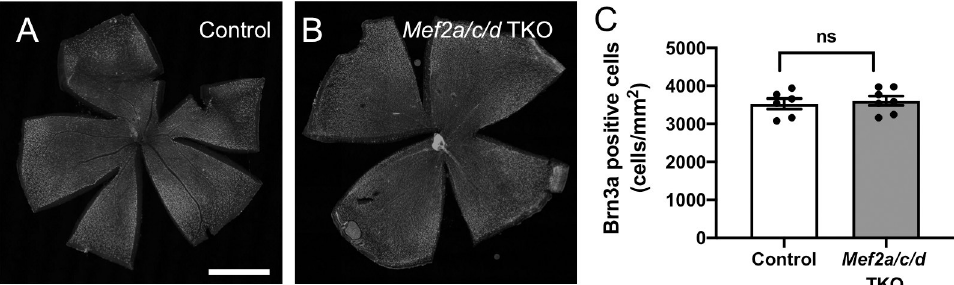
Fig 1. MEF2 is not required for RGC development. (A, B) Flat-mounted retinas from control and Mef2a/c/d mice (TKO) triply targeted using a Chx10-cre driver, immunostained against Brn3a (scale bar, 1 mm). (C) Quantification of Brn3a-positive cells showed no detectable difference in RGC numbers through